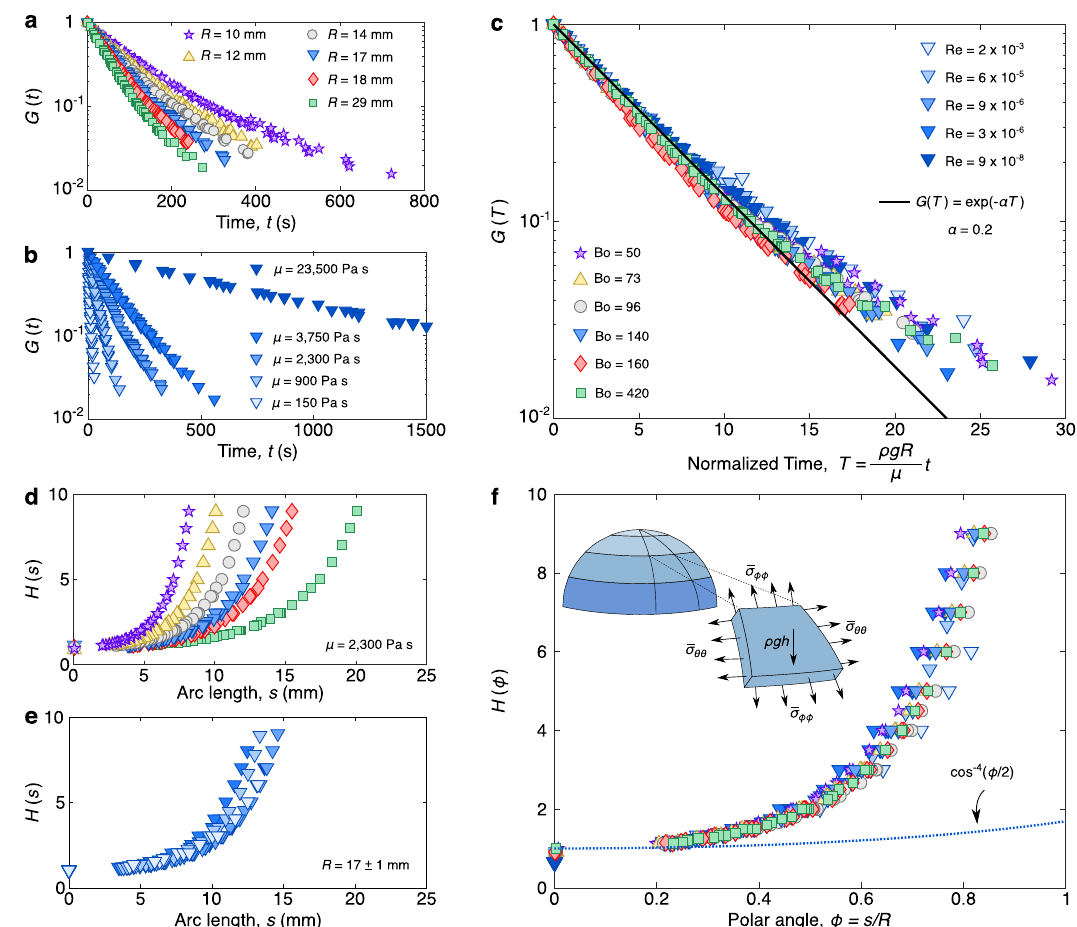
Fig. 3 | Effects of bubble radius and fi lm viscosity on the temporal and spatial evolution of the fi lm thickness. a For a constant fi lm viscosity μ =2300Pas, increasing in the bubble radius leads to faster drainage. b For a constant bubble radius R ≈ 17mm, increasing the fi lm viscosity prolongs the lifetime of the bubble. c Plotting the temporal function G ( T ) against the dimensionless time T = ρ gRt / μ leads to the collapse of the different data sets onto a single curve. The data follow anexponentialdecay (solidline) of the form G ð T Þ = exp ð(cid:2) α T Þ , with a decay rateof α =0.2. d Thespatialfunction H ( s )variesmoregraduallyalongthesurfaceoflarger